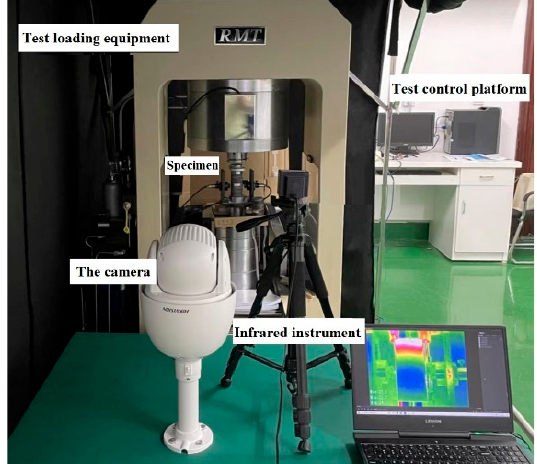
Figure 1. Test equipment.